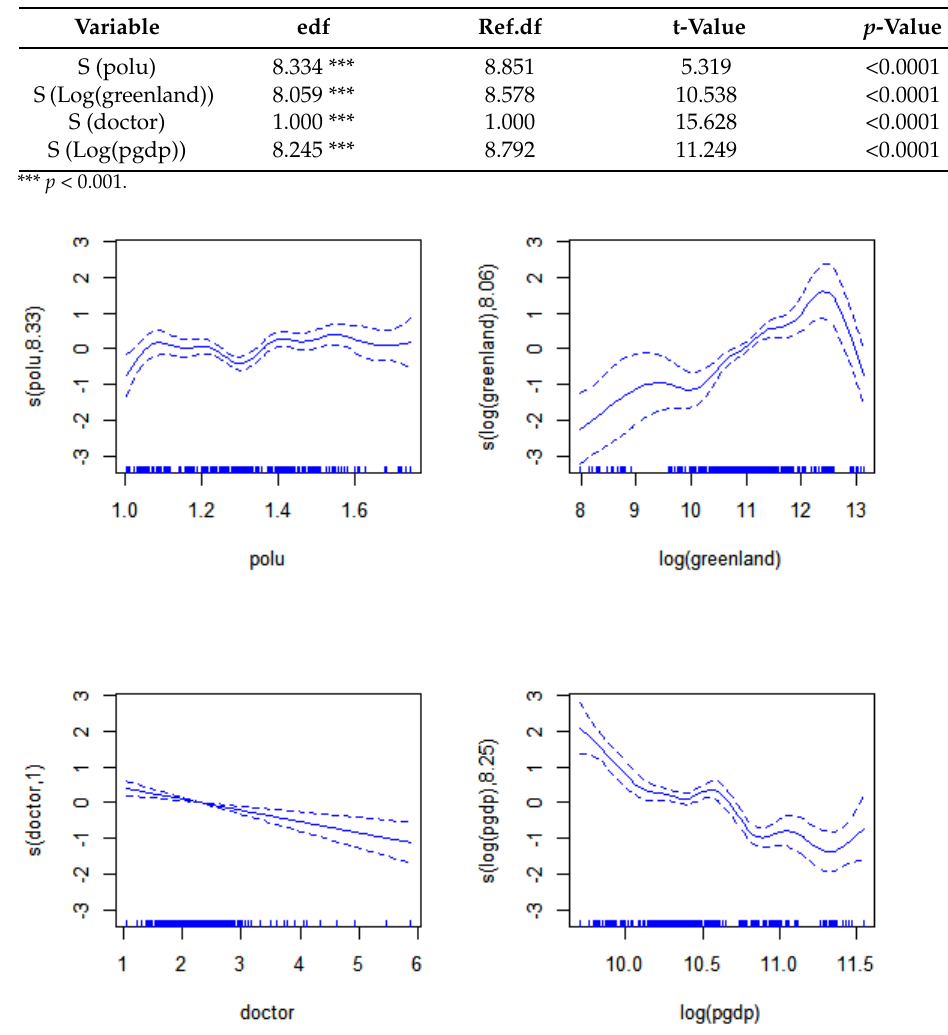
Figure 1. The nonlinear effect of environmental status on